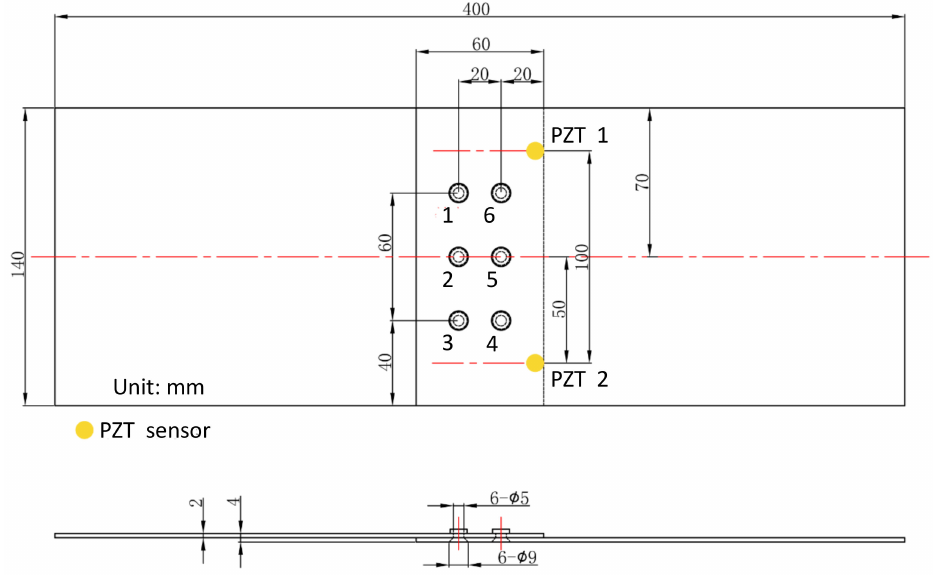
Figure 4. Specimen dimensions and sensor layout.